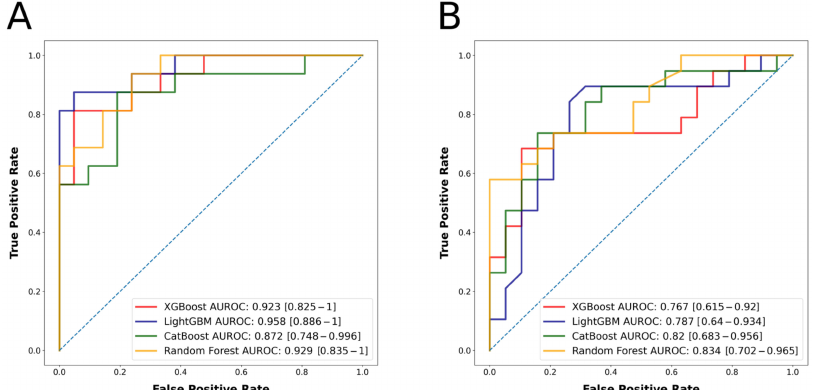
Figure 1. ( A ) Algorithms’ receiver operating characteristic curves for the outcome mRS at 90 days. ( B ) Algorithms’ receiver operating characteristic curves for the outcome NIHSS shift.